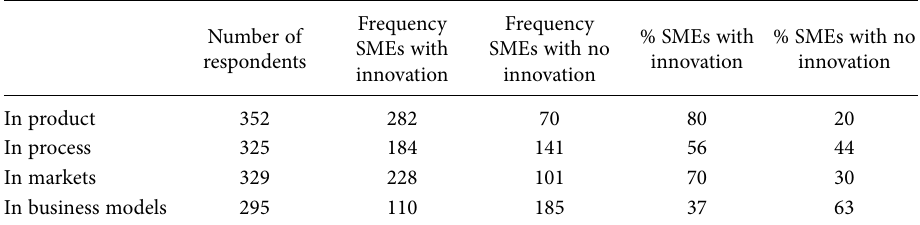
Table 4. Frequency of SME